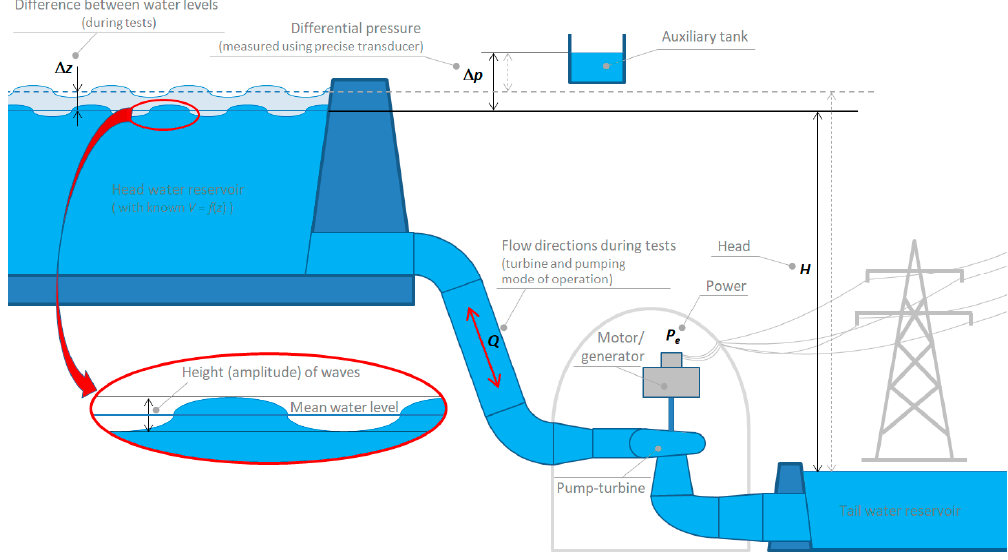
Figure 2. The water level change measurement technique used in the volumetric gauging method.